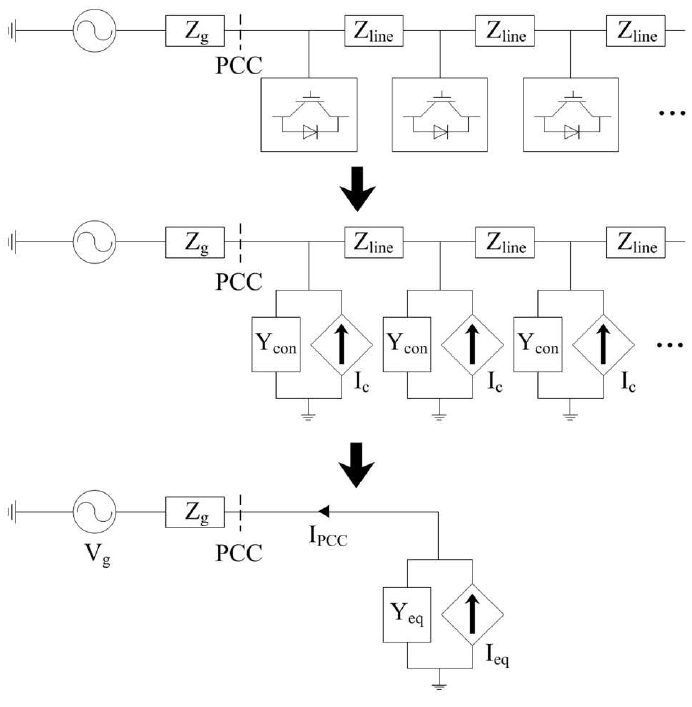
Figure 8. Equivalent model of multiple grid-connected converter-interfaced generators